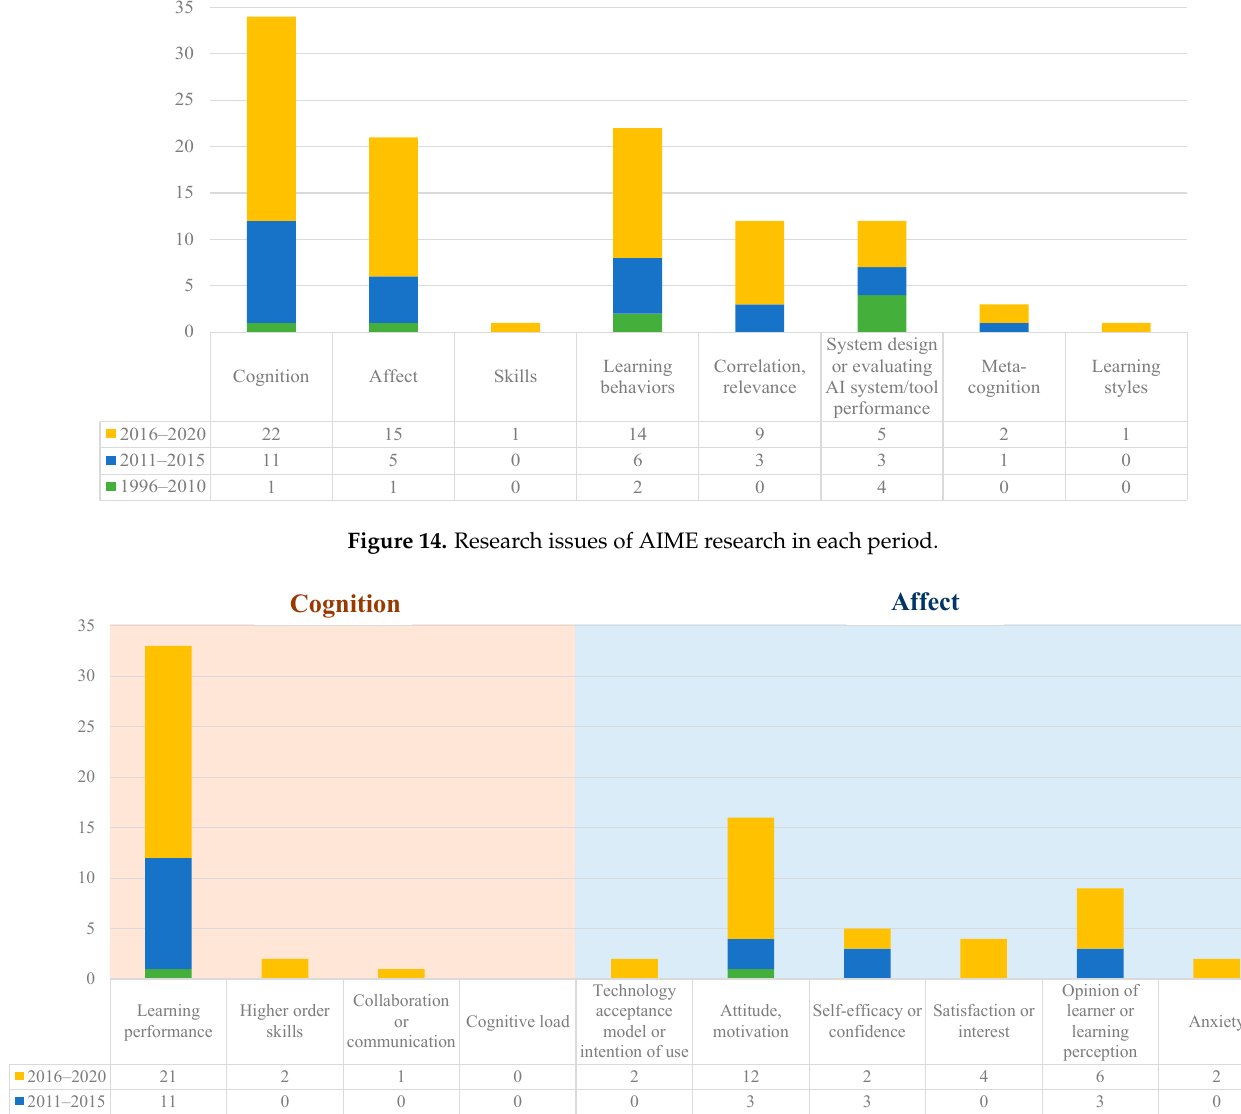
Figure 15. Research issues in the cognition and affect aspects.